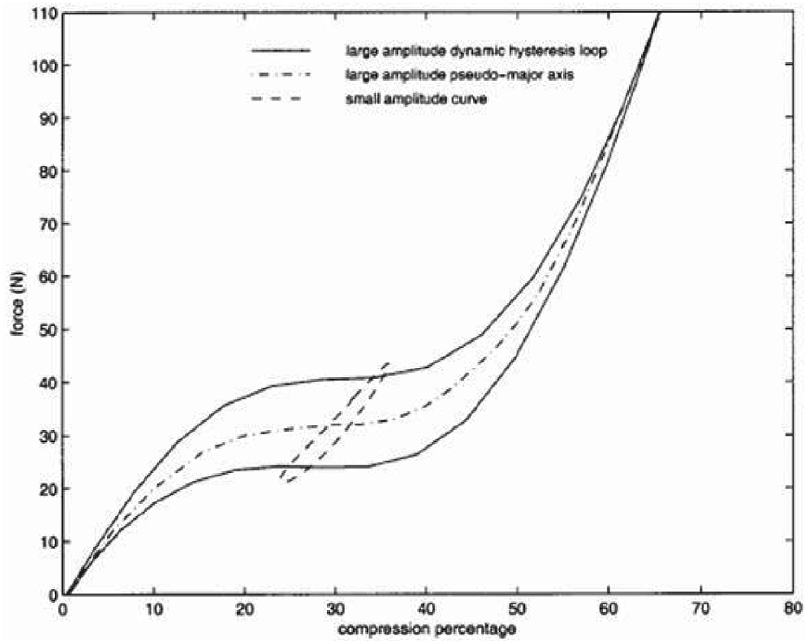
Fig. 23. Typical force/deflection curves for high and low amplitude, single frequency strain cycling of polyurethane foam (Courtesy of White et al. [20]).